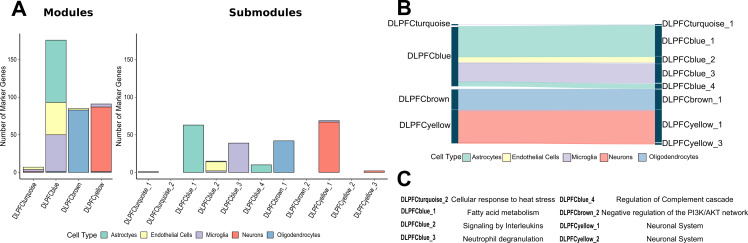
Cell-type specificity of modules is refined in submodules.(A) Cell-type specific marker genes reported by McKenzie et al. were used to annotate modules and submodules for astrocytes, endothelial cells, microglia, neurons, and oligodendrocytes. The top 100 marker genes for each cell-type were used. The iterativeWGCNA procedure generated submodules that were more cell-type specific than their modules of origin. (B) A Sankey diagram demonstrating which cell-type specific markers from modules were found in submodules for the ROSMAP cohort. (C) The top enriched Reactome pathways for ROSMAP submodules based on gene set enrichment analysis.